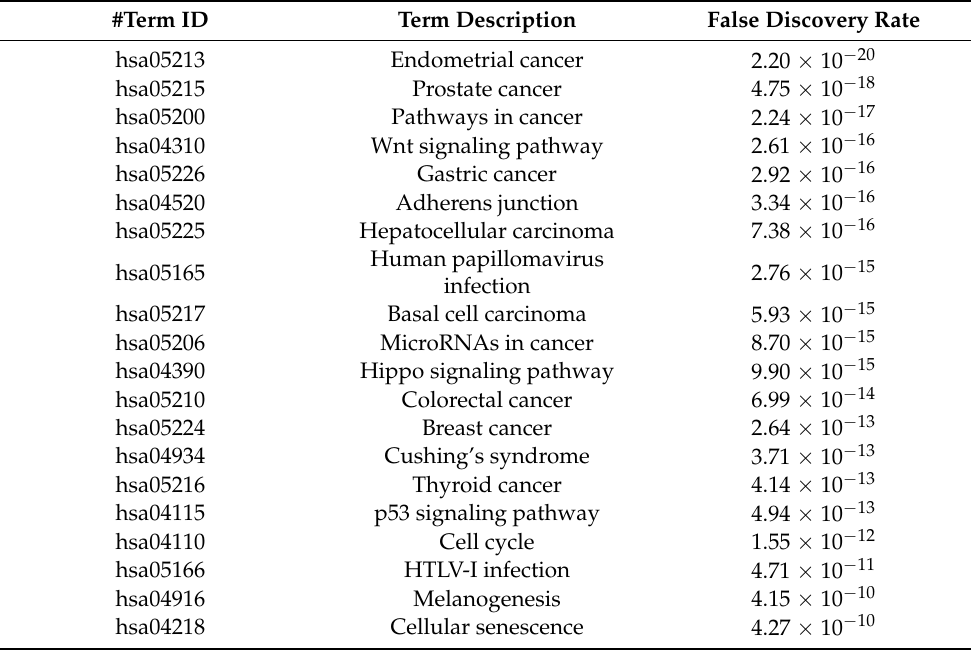
Table 1. KEGG pathway analysis of individual functional protein partners correlated with the three SOX genes.